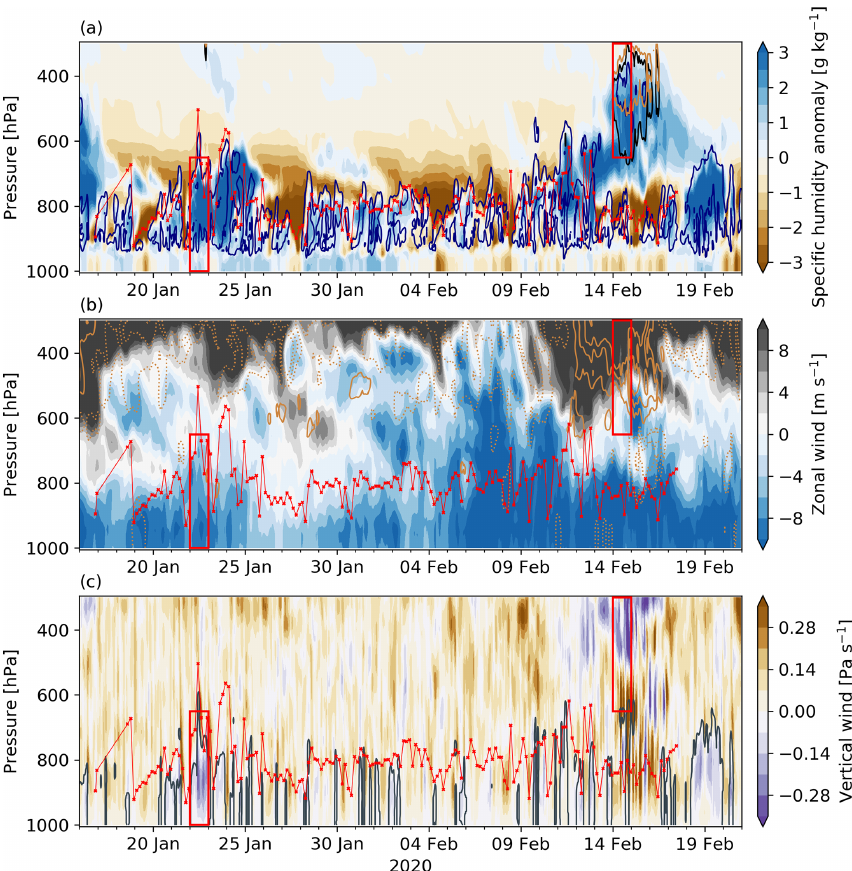
Figure 2. Time series of vertical profiles from ERA5 of the environmental conditions at the BCO during EUREC 4 A and height of the lowest temperature inversion (of at least 0.4 ◦ C over the depth of the inversion) derived from the BCO soundings (red lines with dots). Shown are (a) the anomaly in specific humidity relative to the level-specific campaign mean, liquid (blue contour), snow (black contour), and ice (brown contour) water content (10 mgkg − 1 ); (b) the zonal (color shading) and meridional wind (5, 10, 15ms − 1 , dotted lines for negative values); and (c) vertical wind (color shading) and rain water content (black contour for 1mgkg − 1 ). A Gaussian filter was applied to all variables for better readability. The red boxes highlight the layers and periods of the two case studies. The time axis is given in UTC (Barbados local time: UTC −